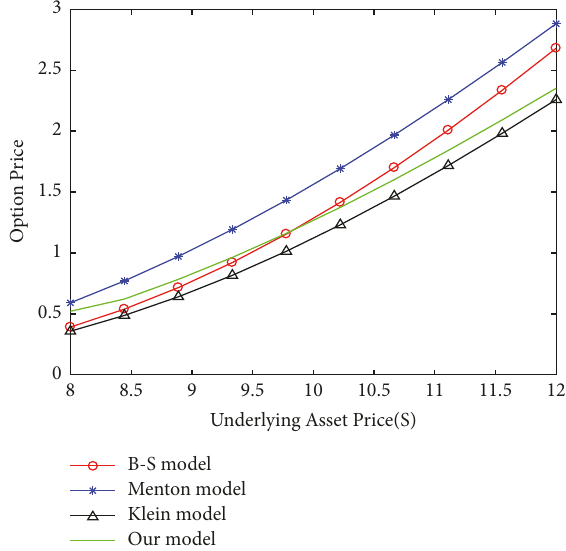
Figure 1: The price of vulnerable call option with incomplete information and other three classical models.